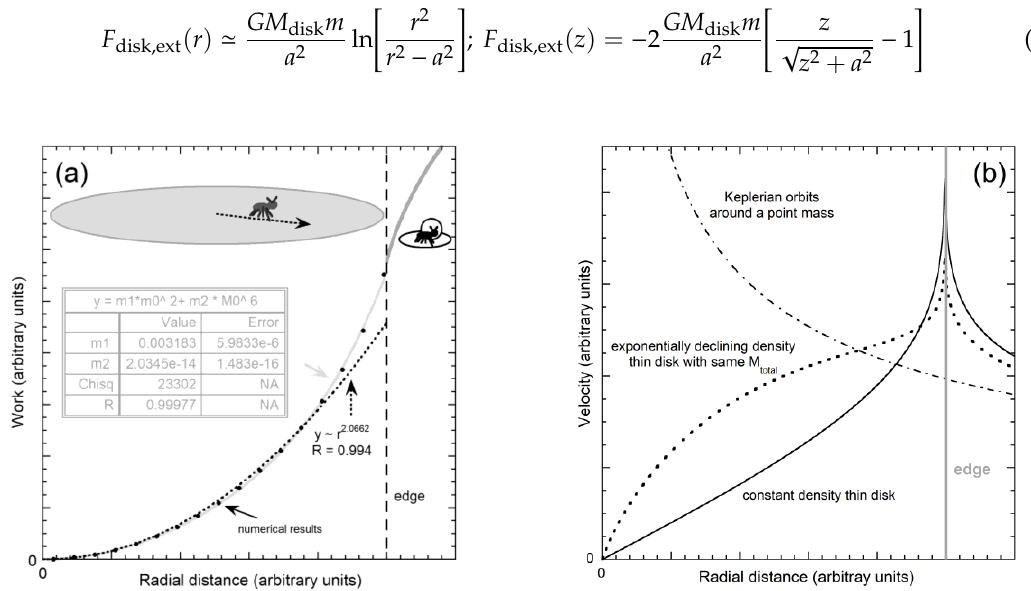
Figure 10. Energetics of ultrathin disks: ( a ) Numerical calculation of work (dots) done by a test particle (the ant) as it crawls across a disk surface with constant density. Nearly 10 6 point masses were used in our integration. Light gray curve and inset shows a two-parameter fit. Dotted curve shows a rough power law. Dark gray curve shows a numerical calculation for the work done at r > a by an external test particle (ant in spacesuit); ( b ) Numerical calculations of velocity inside and outside an ultrathin disk for homogeneous density (solid) and for an exponentially decaying density but with the same mass (dots), showing a discontinuity at r = a . Keplerian orbits (dot-dashes) match these curves at several body radii, as expected. Weakening the exponential decline (moving mass outwards) would provide an RC less steep at the center, but steeper on the outside, moving the peak at r = a closer to the RC for constant density. Strengthening the exponential (concentrating mass inwards) would provide an RC that is steeper at the center and flatter in the middle, such that the peak at r = a is weaker, while remaining higher than the Keplerian orbit al constraint for r > a .